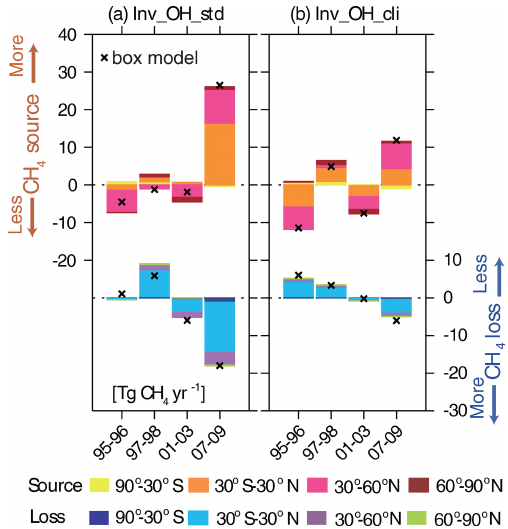
Figure 5. Anomaly of CH 4 emissions and losses estimated by vari- ational 4D inversions (bars) and by two-box model inversions (“ × ”) using a multimodel mean scaled OH (Inv_OH_std, a ) and climato- logical OH (b) during four time periods. The anomalies are calcu- lated by comparison with the mean CH 4 emissions of Inv_OH_cli over the four time periods (494Tg). The total emissions and loss over southern extratropical regions (90–30 ◦ S), the tropics (30 ◦ S– 30 ◦ N), the northern temperate regions (30–60 ◦ N), and the northern boreal regions (60–90 ◦ N) are shown by different colors within each